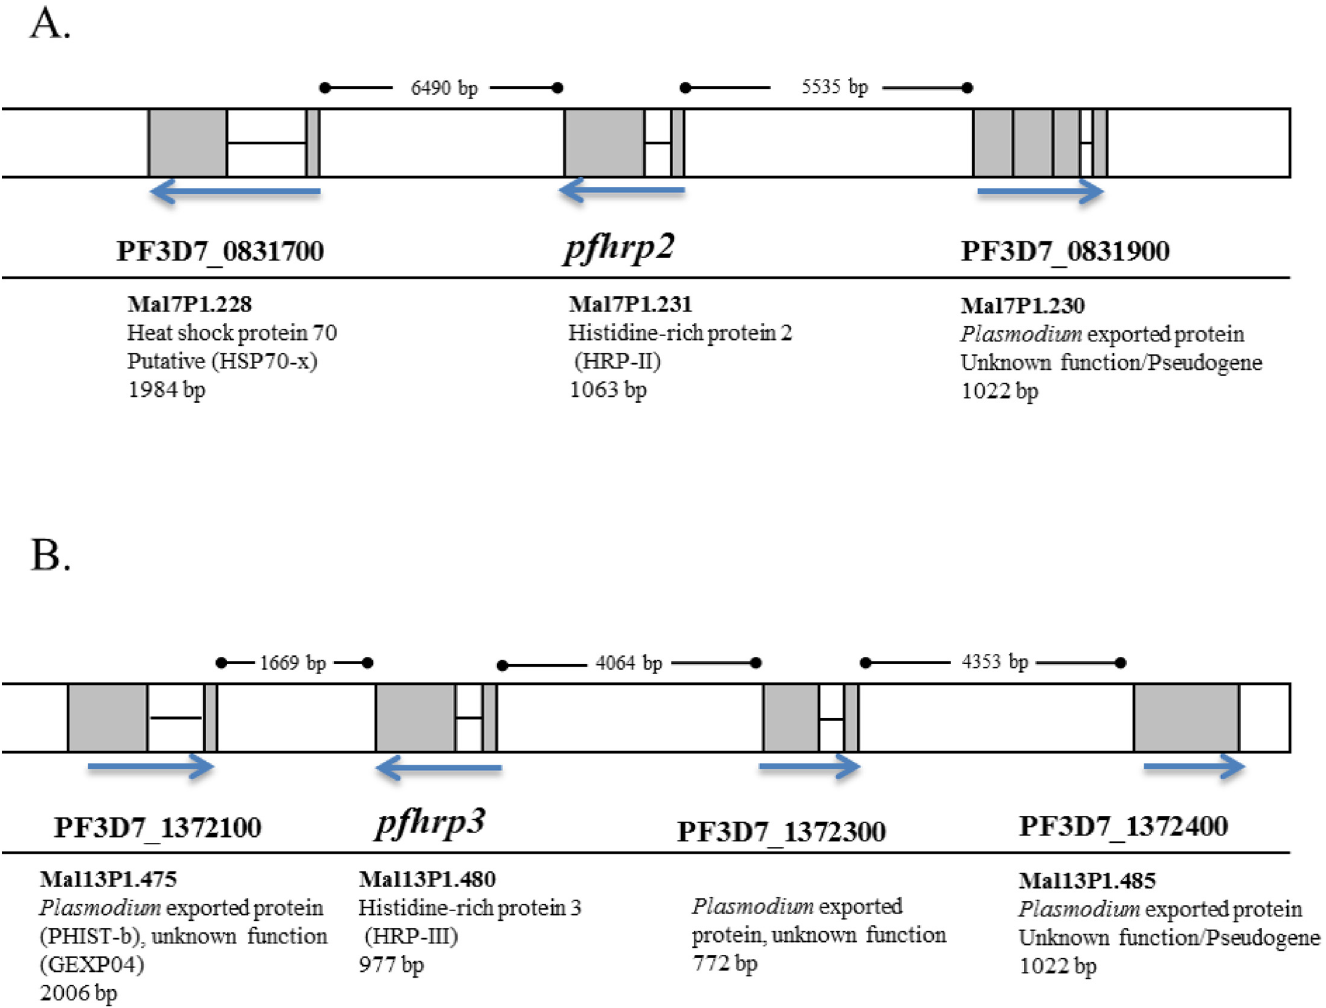
Fig 1. Schematic of the structure of (A) pfhrp2 (B) pfhrp3 and their respective neighboring genes. Pfhrp2 is located subtelomerically on chromosome 8 while pfhrp3 is located within the non-telomeric region of chromosome 13. The old IDs for each gene (MalxP1.xxx), where available, are indicated below the current PlasmoDB designations. Blue arrows indicate the 5 ’ to 3 ’ orientation of each gene. Gene location and information was obtained from PlasmoDB v.9.1